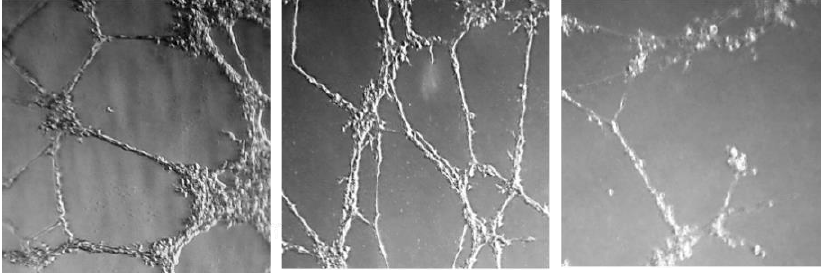
Figure 4. Effect of 23 at 0.25, 0.5 and 1 µM concentrations (from left to right).